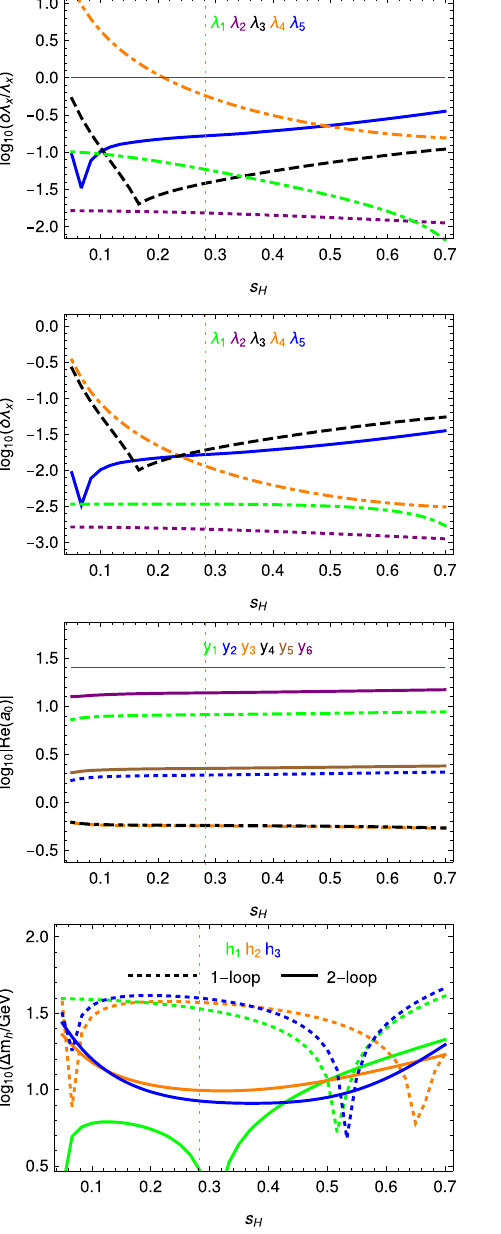
of ( m h , m H ,α) with m 5 = 300 GeV , λ i = 0 . 2 and r 12 = 0 . 15. The vertical orange dashed line shows the HiggsBounds limit